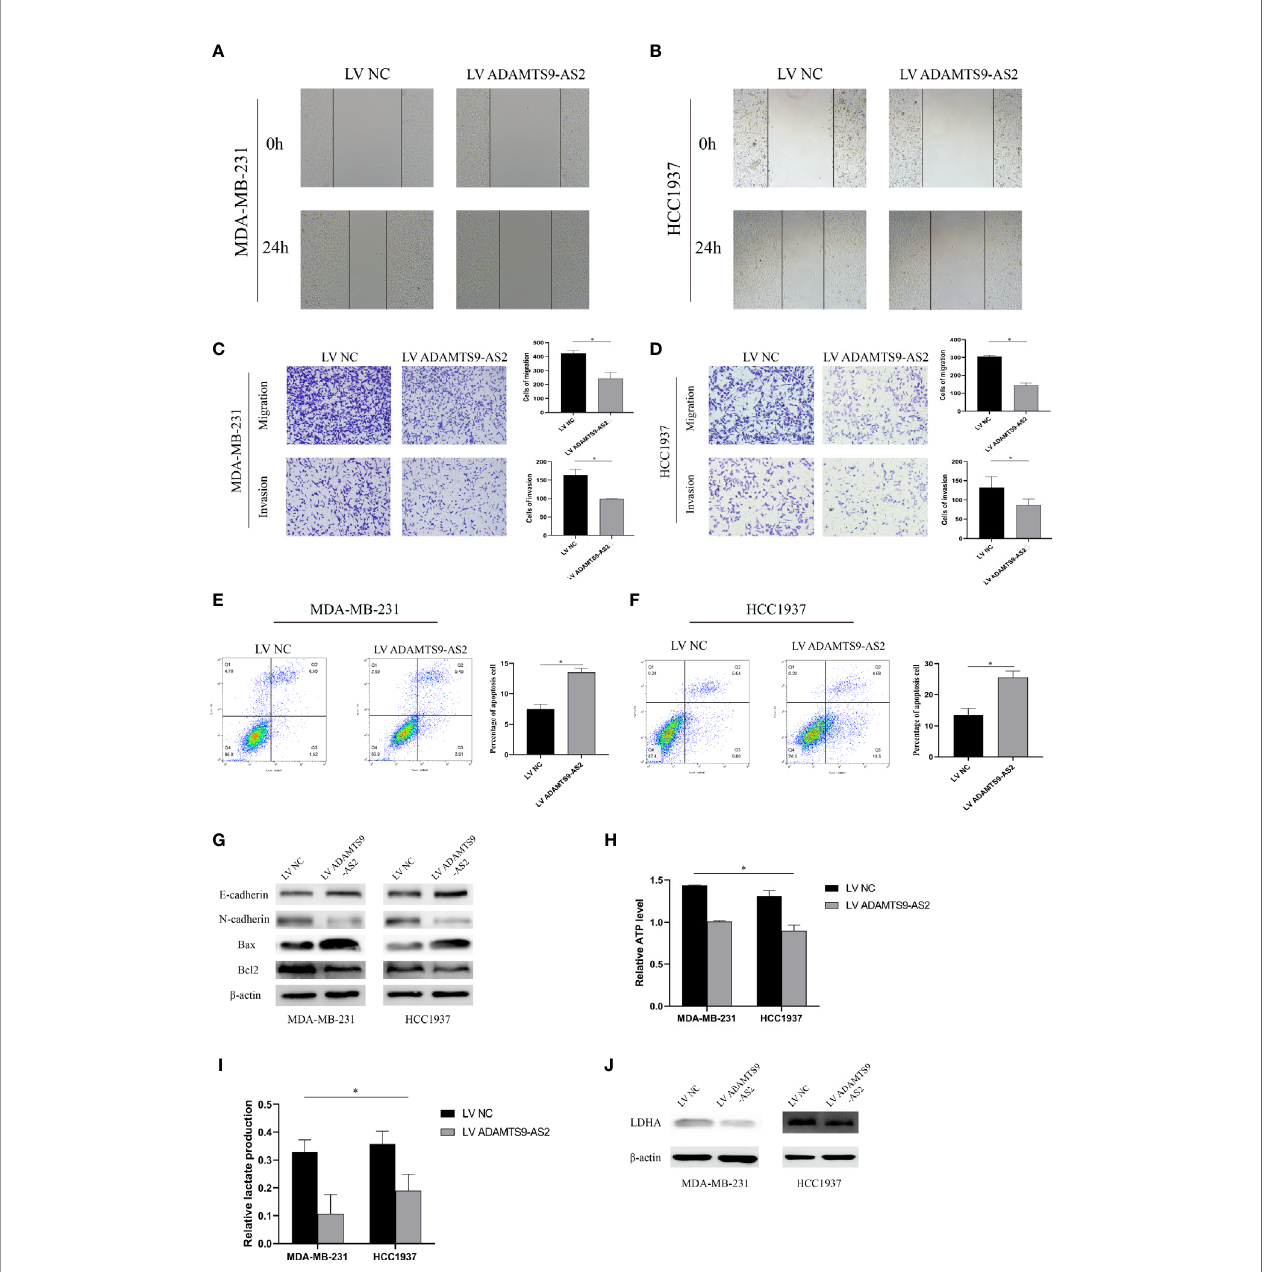
FIGURE 3 | ADAMTS9 ‐ AS2 regulates TNBC cell invasion, metastasis, and cell cycle progression and inhibited Warburg effect. (A, B) Cell migration capacities were detected by wound healing assays after transfected with indicated vectors. (C, D) Cell migration and invasion abilities were determined by transwell assays after transfection. (E, F) Apoptosis rate of TNBC cells was analyzed by fl ow cytometry after LV ADAMTS9-AS2. (G) The expression levels of apoptosis-related and epithelial-mesenchymal transition process marker proteins were determined by western blot. (H, I) Production of lactate and ATP were examined in TNBC cells transfected with LV ADAMTS9-AS2 or LV NC as indicated. (J) related LDHA expression was detected by western blot. *P <